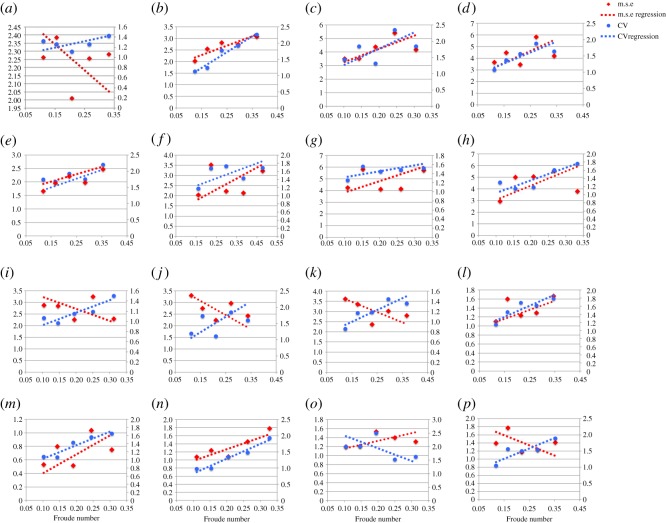
(a–p) RMA regression suggested positive linear relationships between m.s.e. (y axis) and Froude number in 11 out of 16 subjects, and CV (z axis) and Froude number in 15 out of 16 subjects. However, R2 and p-values (r2 > 0.75, p = <0.05) strongly support linear increases in variability with Froude in only four subjects when assessed by m.s.e. in four subjects, and in 11 subjects when assessed by CV (table 3). Froude number is (Fr = v2/g × LL), where v2 is speed squared, g is gravity (9.81 m s−2) and LL is each subject's leg length measured from the superior apex of the iliac crest to the where the heel meets the floor.